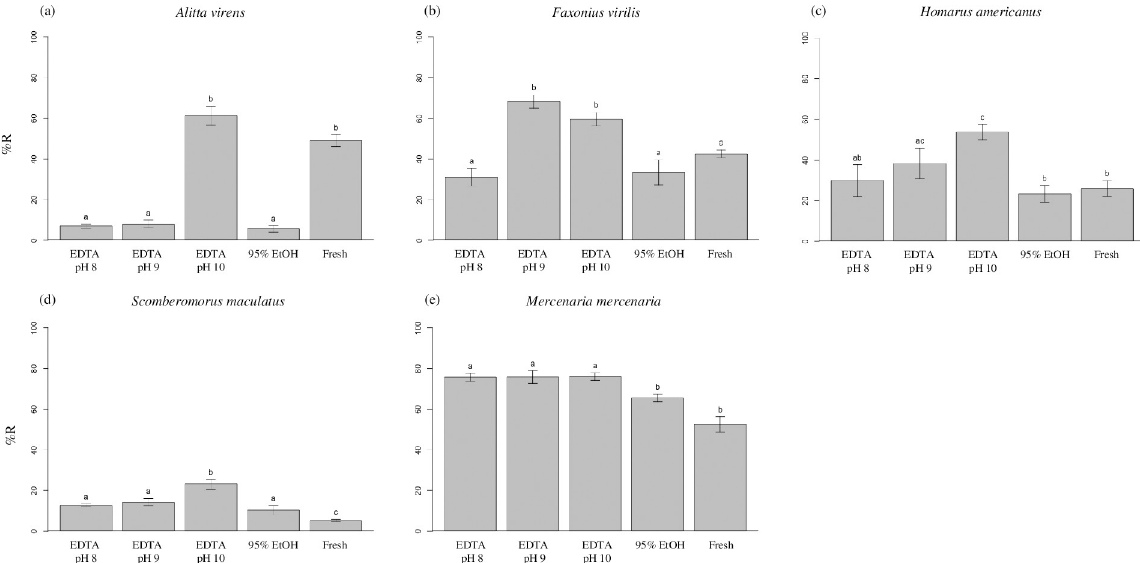
Fig 2. Percent high molecular weight DNA recovered. Average percent high molecular weight DNA recovered (%R) was determined for tissues of (a) Alitta virens , (b) Faxonius virilis , (c) Homarus americanus , (d) Scomberomorus maculatus , and (e) Mercenaria mercenaria that were either extracted immediately from fresh tissue or stored for 12 months at room temperature in 0.25 M EDTA adjusted to pH 8, 9, or 10, or 95% ethanol. Error bars represent standard error. Within this figure, treatments bearing different lower-case letters are significantly different at the Bonferroni-adjusted p < 0.005; matching lower-case letters indicate statistically indistinguishable treatments. 95% EtOH, 95% ethanol; Fresh, untreated tissue extracted immediately after